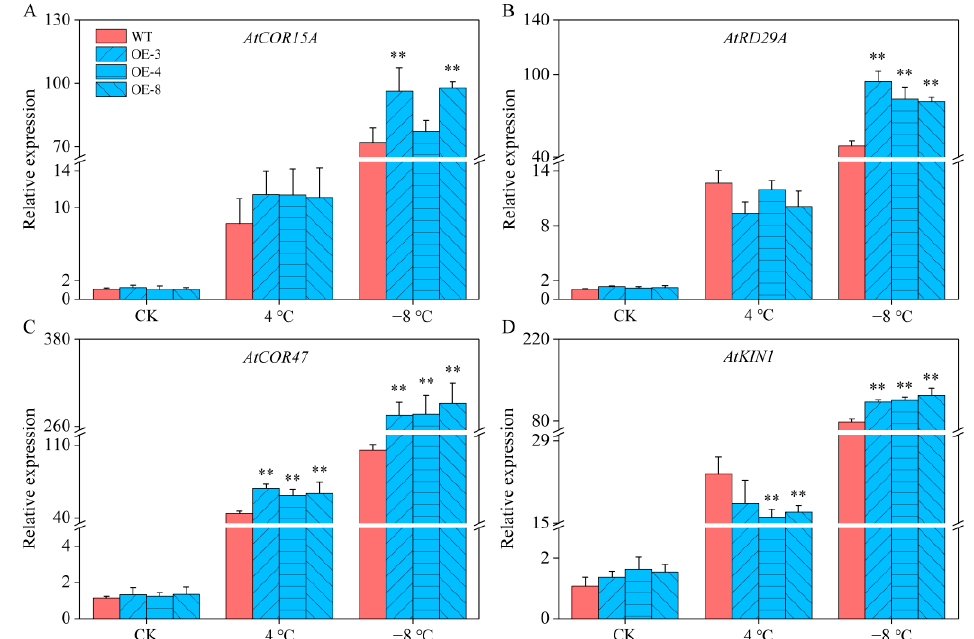
Figure 8. Expression levels of ( A ) AtCOR15A , ( B ) AtRD29A , ( C ) AtCOR47 , and ( D ) AtKIN1 of WT and CaSPDS -OE plants under cold stress. “*” represents p < 0.05, and “**” represents p < 0.01 between WT and transgenic lines.